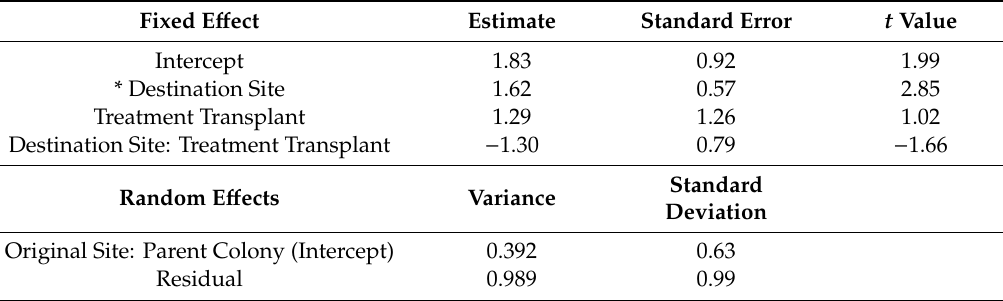
Table 3. Results of the linear mixed e ff ects model for P. compressa dry skeletal